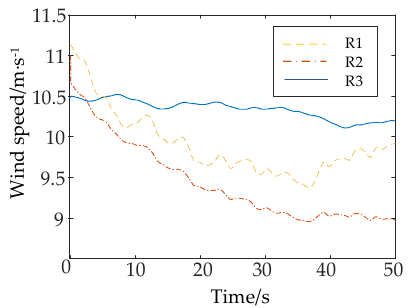
Figure 17. Wind speed curves of variable wind speeds in different subareas of WF. Table 7. Simulation results under middle wind power permeability and variable wind speed condition.